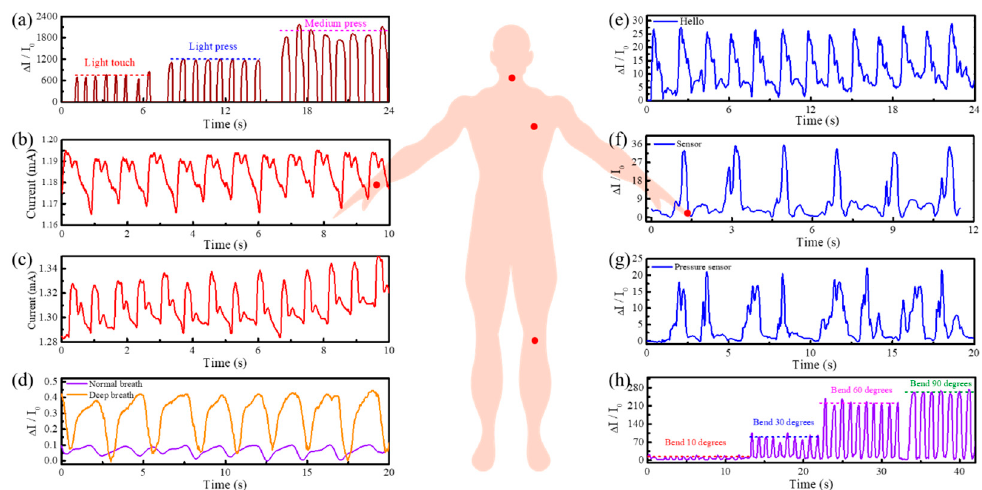
Figure 4. Schematic illustration of human motion and physiological signal monitoring of the pressure sensor. ( a ) Diagram of a sensor touched with various forces. ( b ) Real-time monitoring of the radial artery normal pulse by attaching a sensor to the wrist. ( c ) Exercise pulse test after 1 min of plank. ( d ) Normal breath and deep breath mode test by attaching a sensor to the chest. ( e – g ) Voice recognition by mounting a sensor on the throat to detect vocal cord vibrations. ( h ) Detection of leg swing angles by attaching a sensor to the knee.